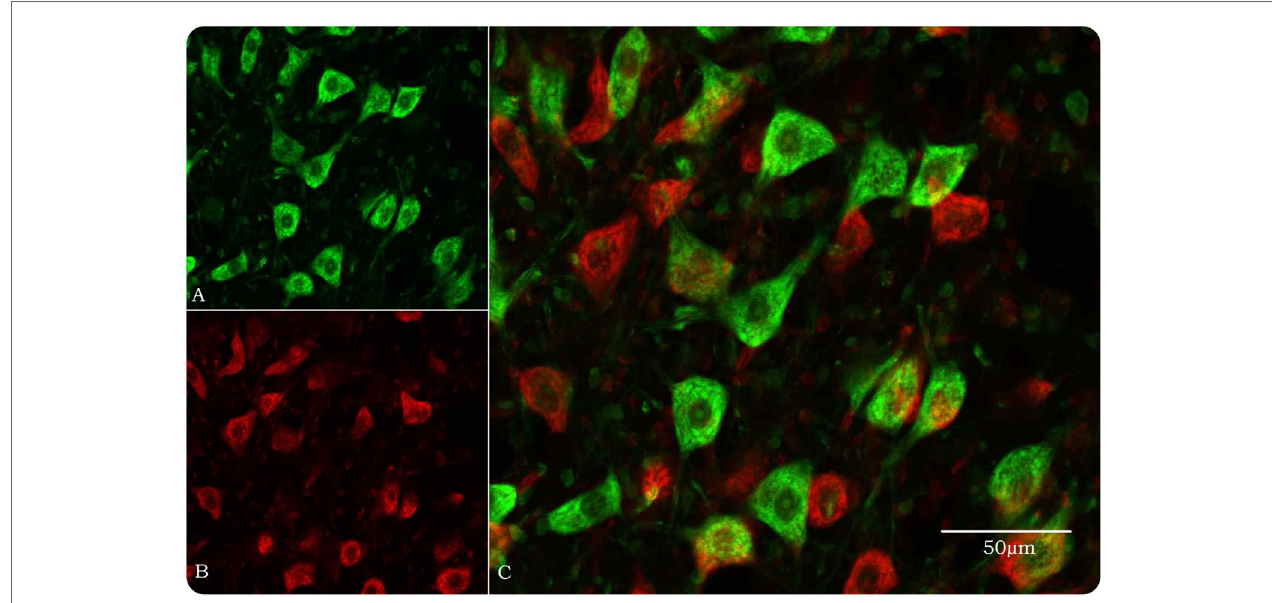
FigUre 1 | Optical disector method in the confocal microscope for stereological estimation of total numbers of facial motor neurons . (a) Motor neurons, pseudocolored green, are identified by their size and morphology when their nucleoli, nuclei, and Nissl bodies are fluorescently stained by YOYO-1 iodide. Neuroglial cells are approximately 20% of the size of motor neurons and easily discounted from counting. (B) Same field as in (a) but with a 10- μ m Z-step and pseudocolored red. (c) Images (a) and (B) merged so that only motor neurons in the look-up section (green) are counted.